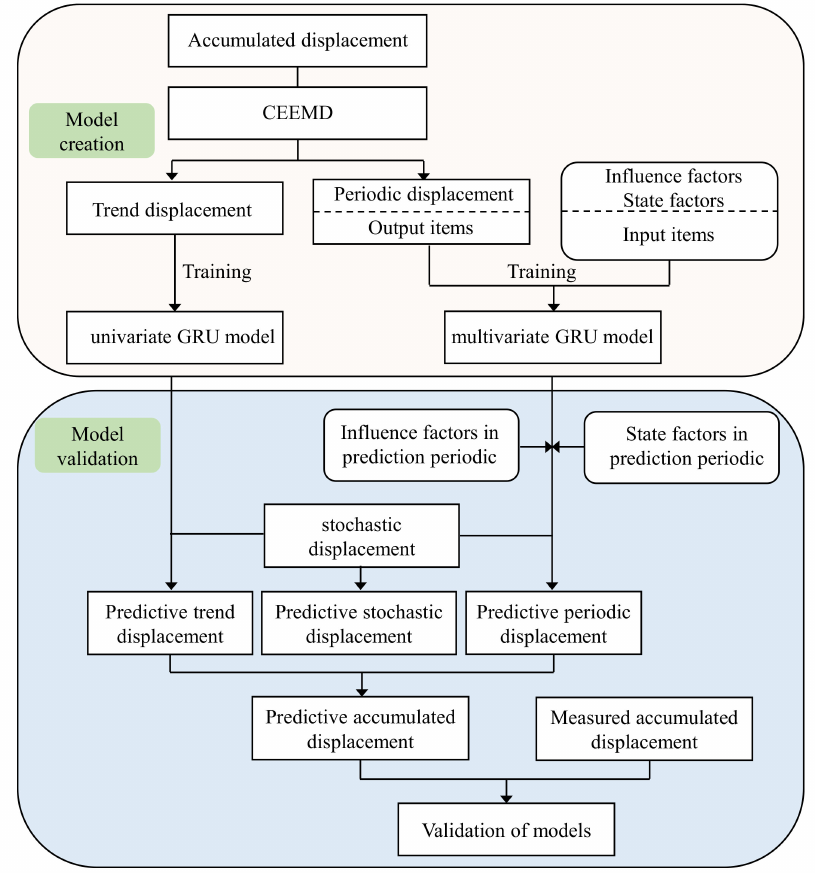
Figure 4. Flowchart of the proposed predictive